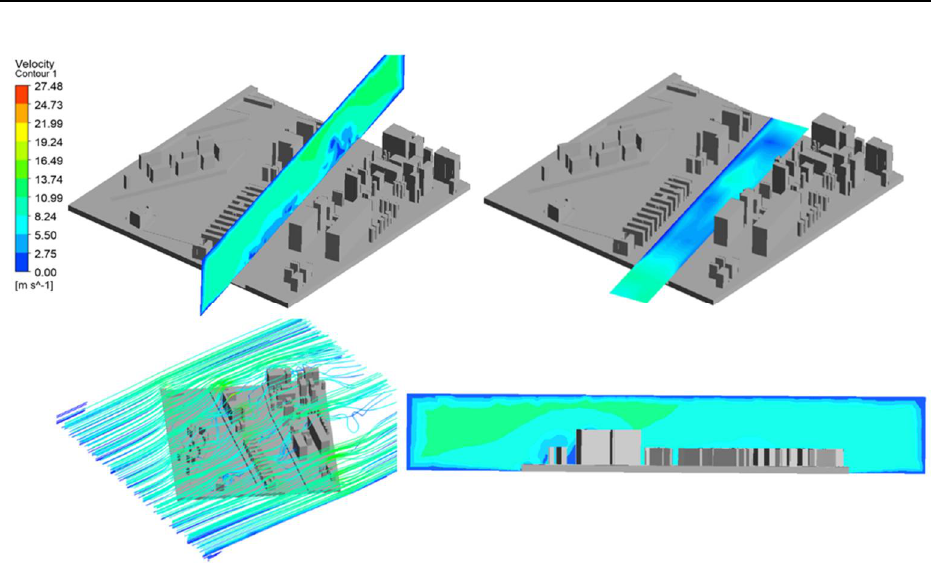
Figure 16. Simulation results presented by means of a contour map.